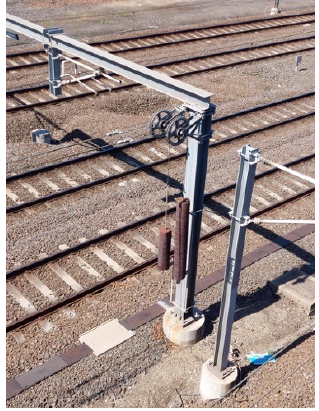
Figure 2. Weight stack and pulley system.